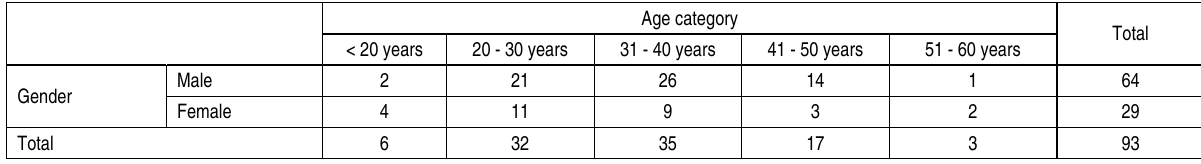
Table 1. Age category of the